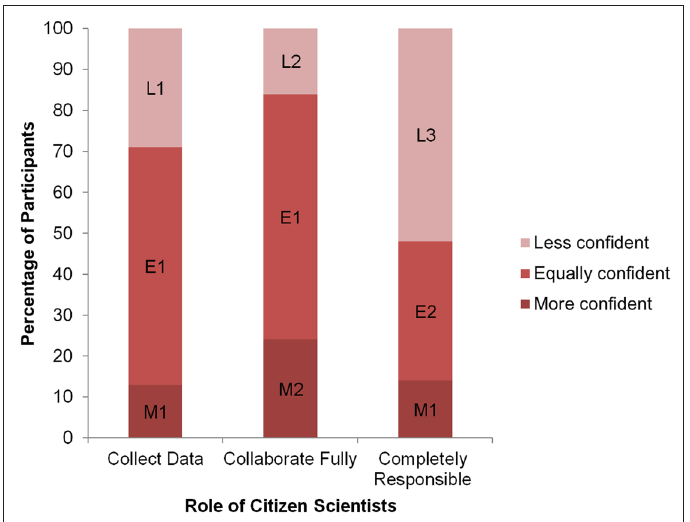
Figure 2: Confidence in citizen science findings compared to those generated by professional scientists. Pairwise comparisons were conducted within each confidence level (e.g. collect data vs. collaborate fully for results of “less confident”). Different number combinations for each letter indicate significant differences (p < 0.05) based on pairwise chi-square tests with Bonferroni corrections. N = total